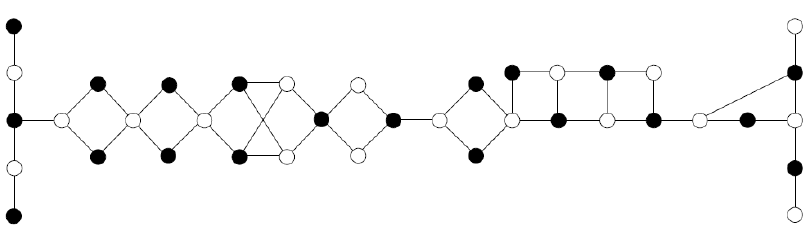
Fig. 7: A generalized H10 with the darkened vertices being the X -partition. Deleting any vertex yields a probe interval graph: removal of any pendant or cut-vertex results in a convex graph, and removal of any other vertex changes all cut-edges to those of the form described in Lemma